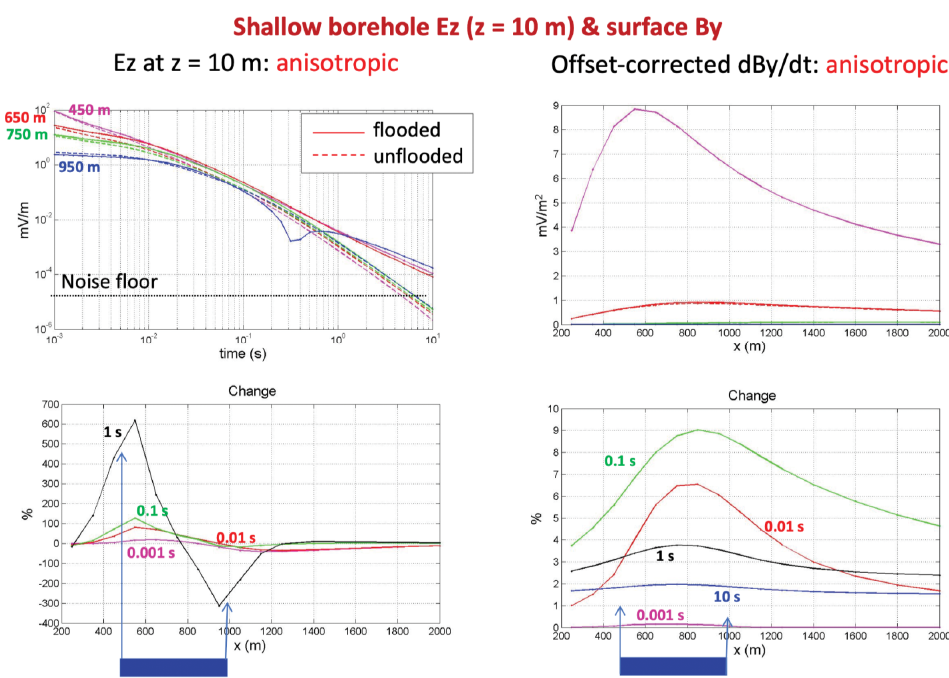
Figure 18. Horizontal electric field response as a function of the distance from the transmitter ( left ) using the isotropic model on from Figure 15. On the ( right ), we added anisotropy to the model resistivities (modified after [41]).